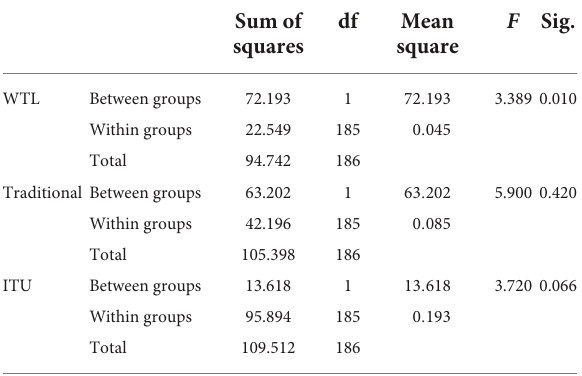
TABLE 5 Literacy and arithmetic test